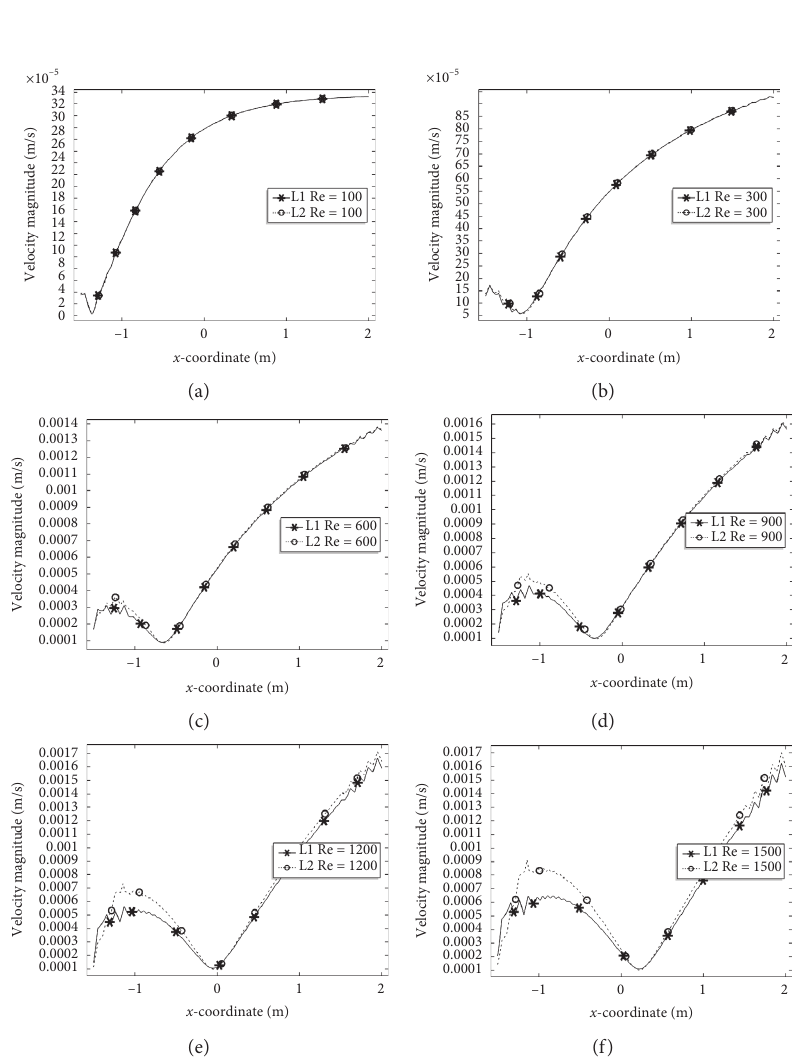
Figure 6: Orientation of the velocity field in Lines L1 and